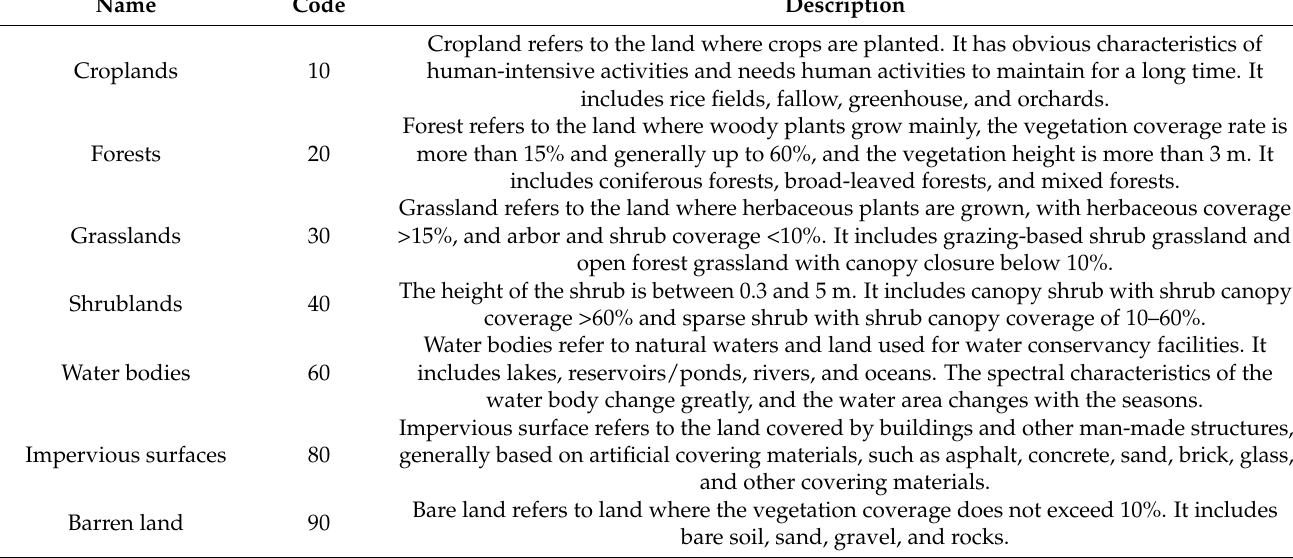
Table 3. Land cover classification